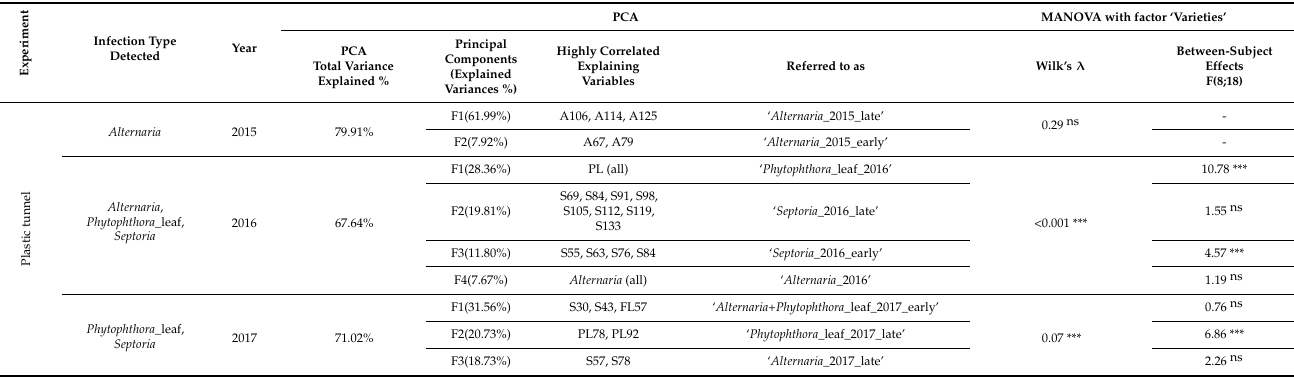
Table 8. The results of the principal component analysis for the infection types of the plastic tunnel experiment: the explained variances of the PCs as well as the total explained variance rates; the original variables that are highly correlated with the PCs (with high loadings) and the names that refer to the PCs later on; Wilk’s λ (unexplained variance rate) values (overall MANOVA results) and the follow-up ANOVA tests (between-subject effects) with F values and their significances. m r i p e E x